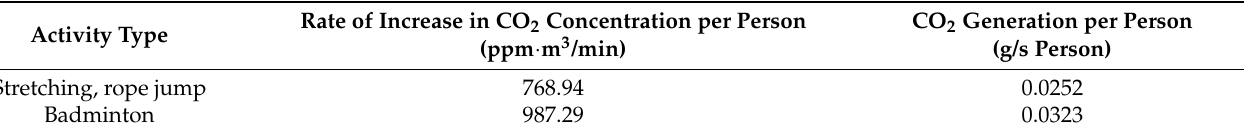
Table 10. CO 2 generation per person per hour for each physical activity in A Elementary school.